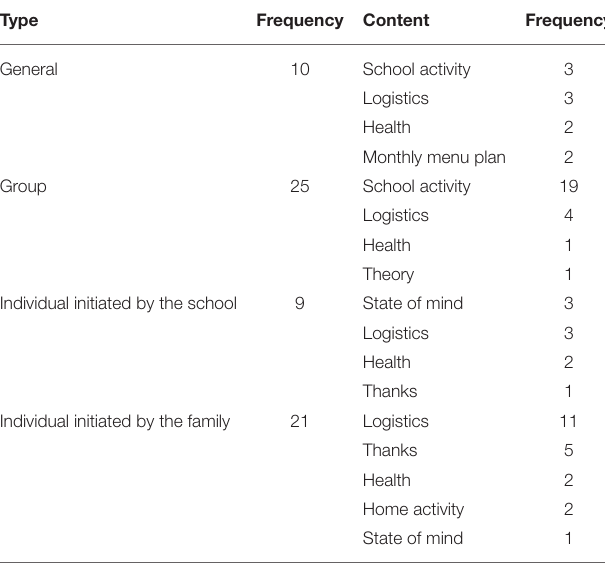
TABLE 2 | Content of mobile app messages according to sender/receiver